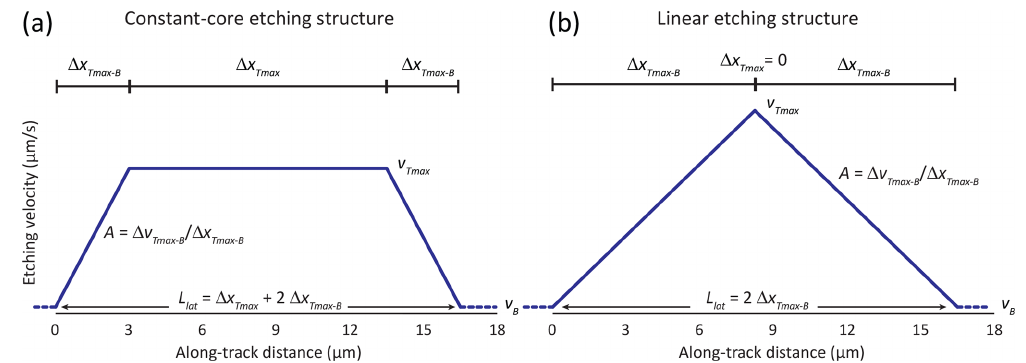
Figure 3. Model schemas for fission-track etching structure. (a) Constant-core. (b) Linear. v Tmax is maximum along-track etching velocity, and v B is bulk grain etching velocity. (cid:49)x Tmax is the width of the constant-etching-rate core, and (cid:49)x Tmax − B is the width of the zone from the core to the track tip. A is the track-etch rate gradient as it falls toward the tip, and L lat is the full latent track length. The intersection point of the etchant pathway with the latent track, x int , can occur anywhere along its length; the etching of the track will begin from that point and follow the etching structure in each